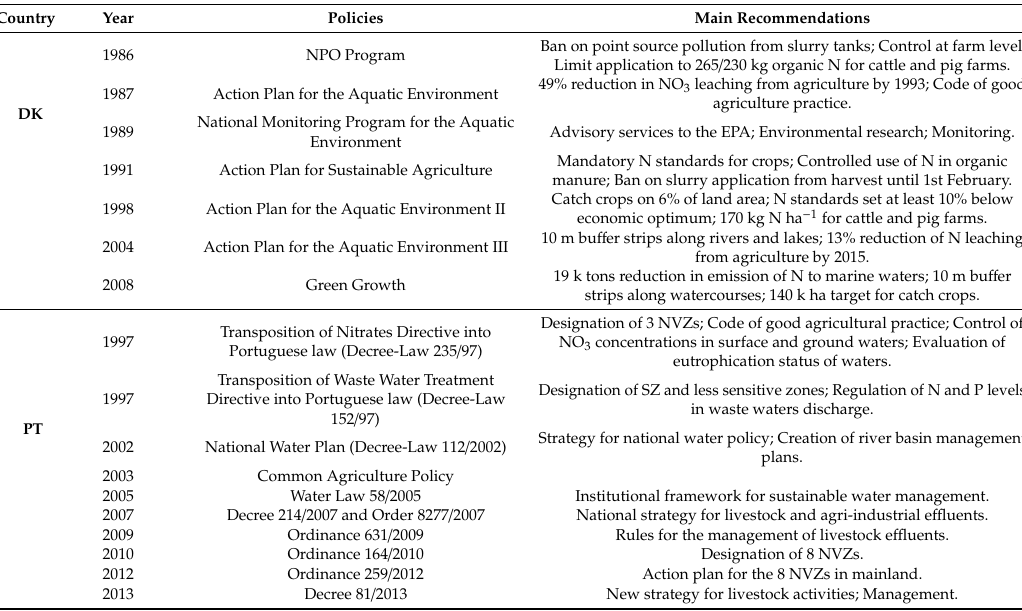
Table 3. Historical nitrogen abatement policies in Portugal and Denmark.